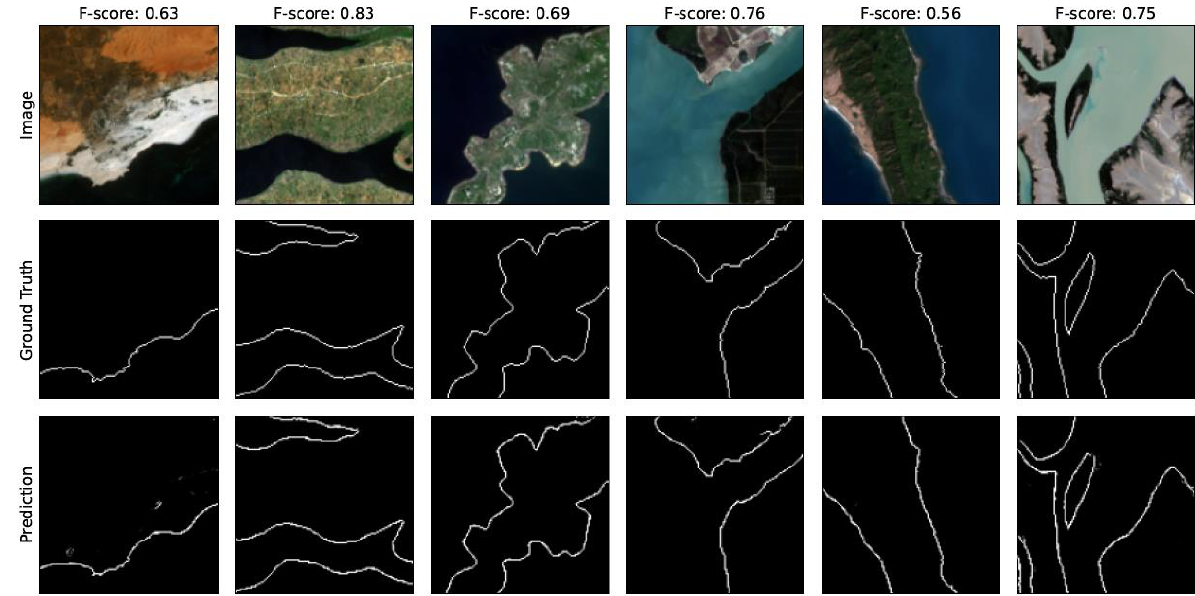
Figure 2. Results from Landsat test data. The F-score for each image is at the top. The first row contains the original RGB image. The second row has the ground truth for each corresponding image. The bottom row has the predictions from the model trained on Landsat data.